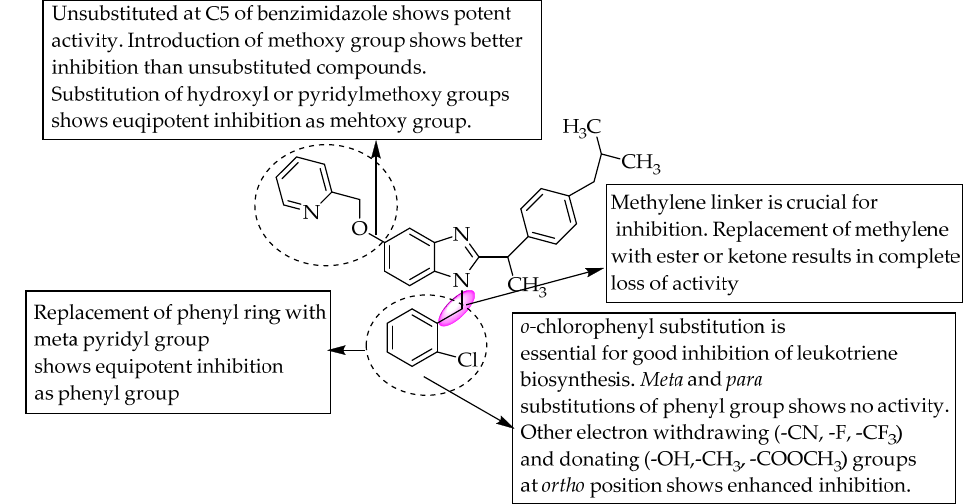
Figure 23 . SARs of 2-isobutylphenylethyl